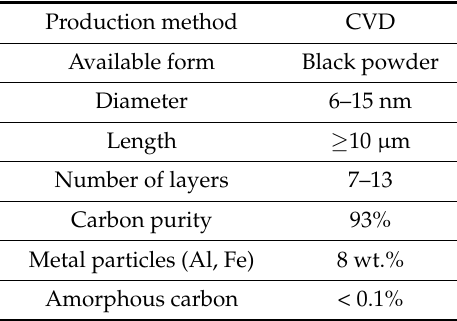
Table 1. MWCNT characteristics as declared by the